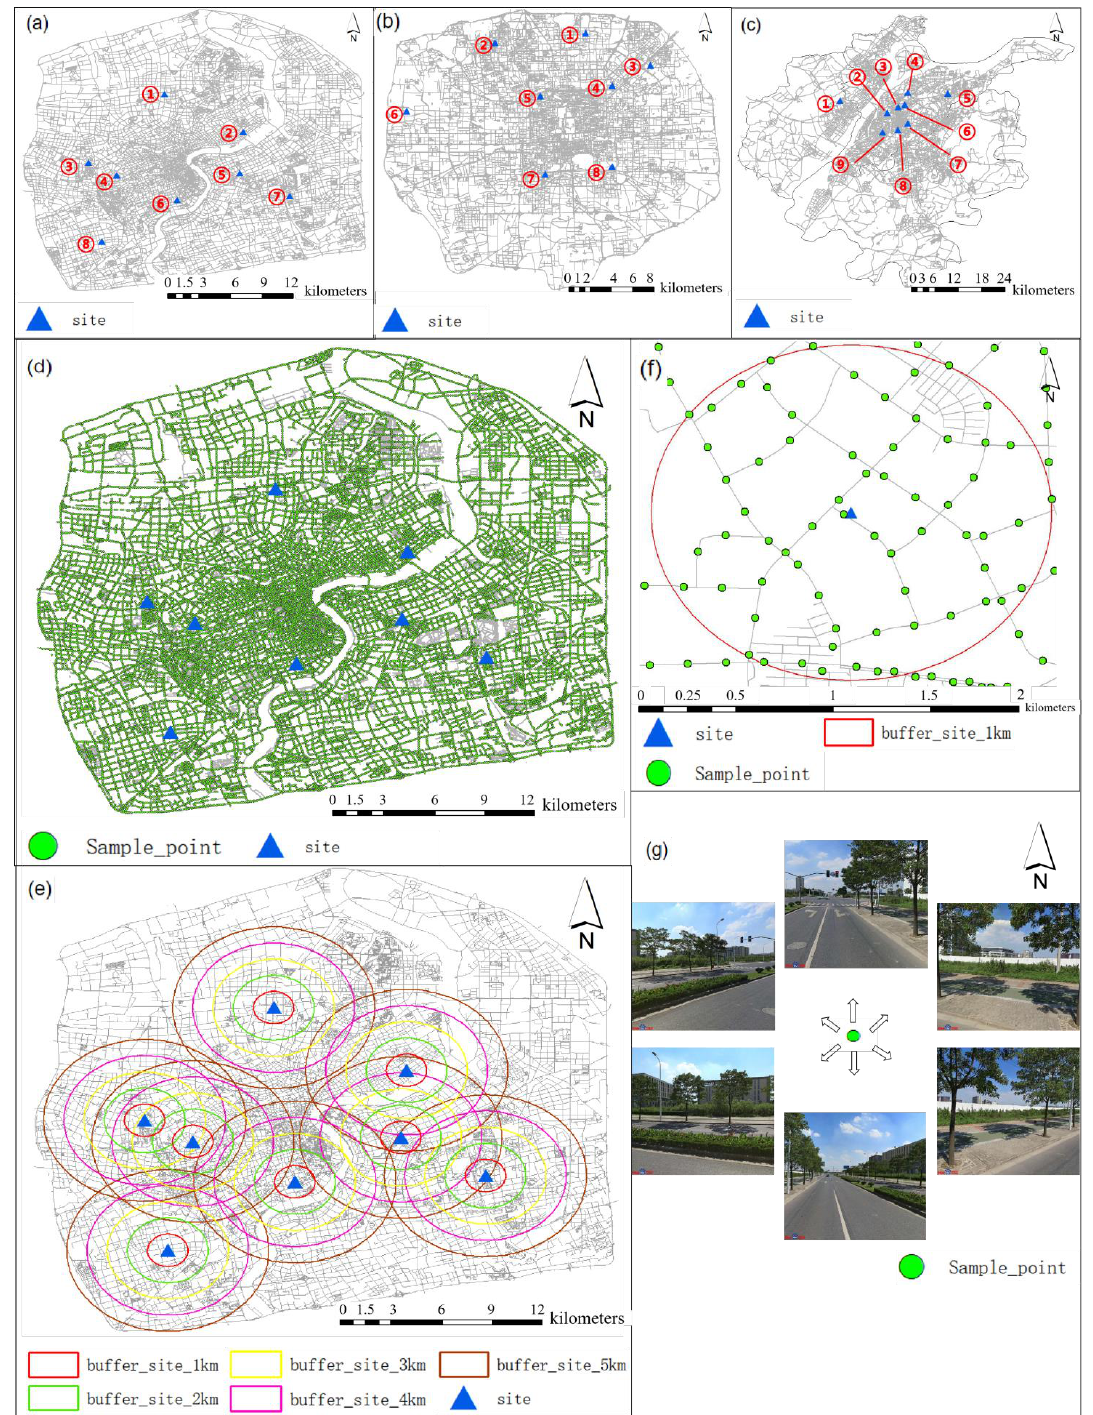
Figure 1. The study area’s distribution of air quality-monitoring sites and street view image data. ( a ) Road network and distribution of air quality-monitoring sites within the outer ring road of Shanghai. ( b ) Road and distribution of sites within the Fifth Ring Road in Beijing. ( c ) Road and distribution of sites within the main urban area of Nanjing. ( d ) Distribution of sampling points along the street within the outer ring of Shanghai. ( e ) For each site, the considered radius was ranged from 1 to 5 km with a 1-km interval. ( f ) Spatial distribution of sampling points around a site. ( g ) At each sampling point, the street view images with six azimuth angles (0, 60, 120, 180, 240, and 300) were collected. The vertical angle is 0 degrees, and the resolution is 600 × 600 pixels.